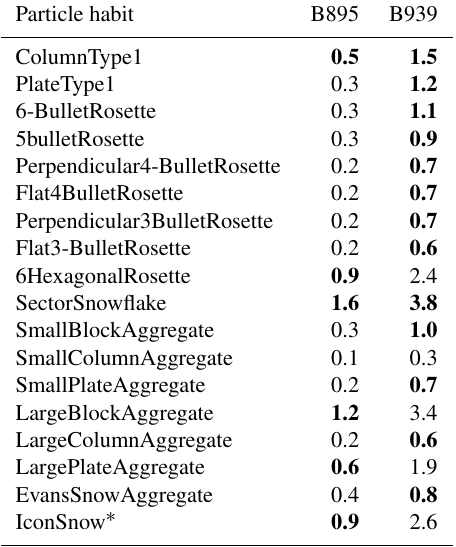
Table 2. Mean IWC ratio for each particle habit and flight. The habits selected for the simulations are highlighted in